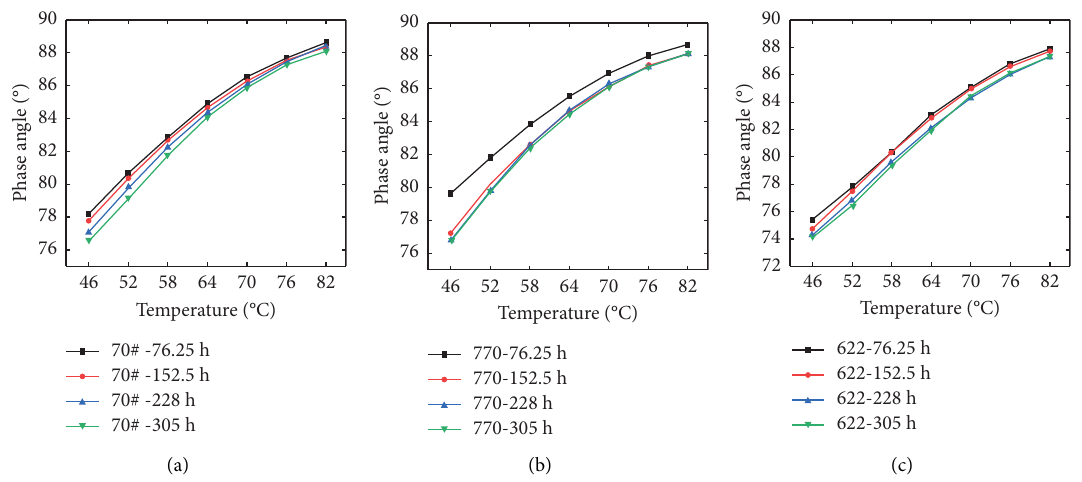
Figure 7: δ variation curves of diferent types of asphalt with UV aging time (a) 70#. (b) T770. (c) T622.